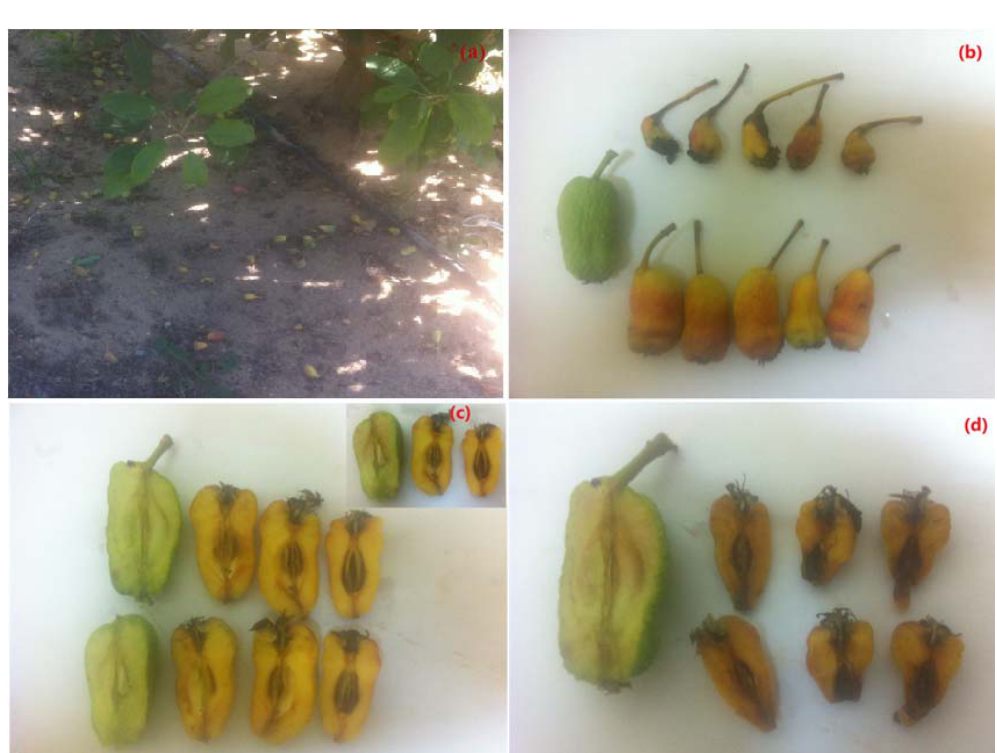
Figure 1. An “Anna” apple tree showing natural fruit drop ( a ), collected dropped apple fruit ( b ), internal tissues of dropped apple fruit showing core browning ( c , d ), fruit were about half their final size.